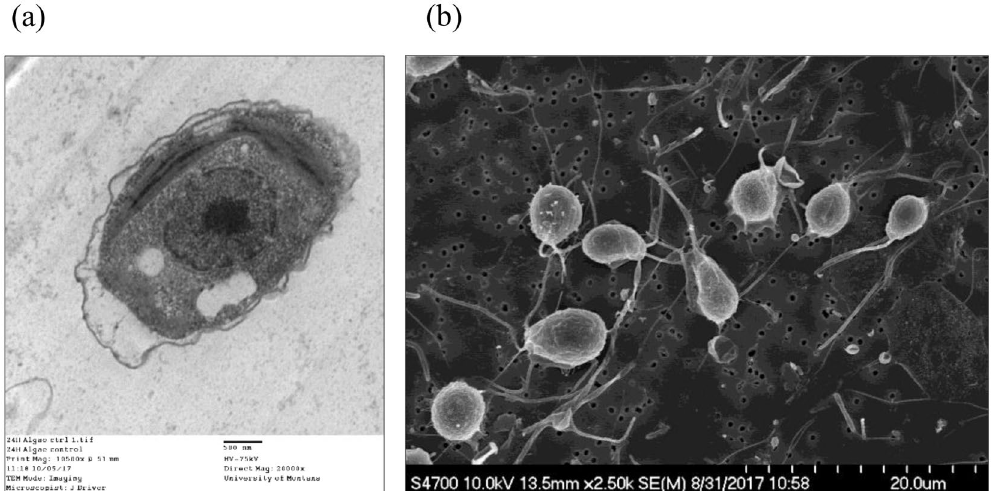
Figure 5. TEM image ( a ) and SEM image ( b ) of algae of control